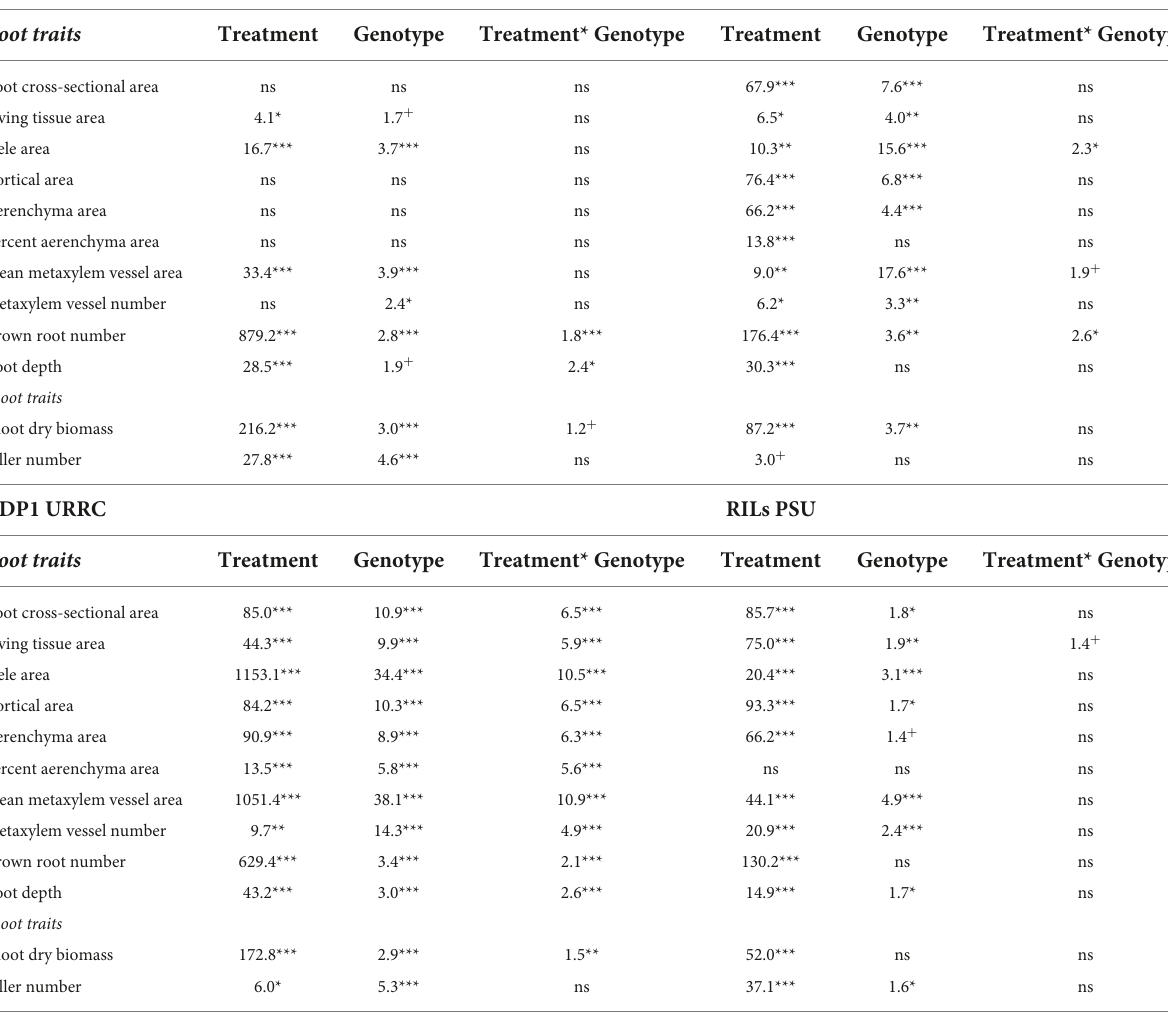
TABLE 2 ANOVA table showing the effect of drought treatment, genotype, and interaction effects on nodal root anatomical traits, root architectural traits, and shoot traits within each experiment location. RDP1 IRRI RDP1